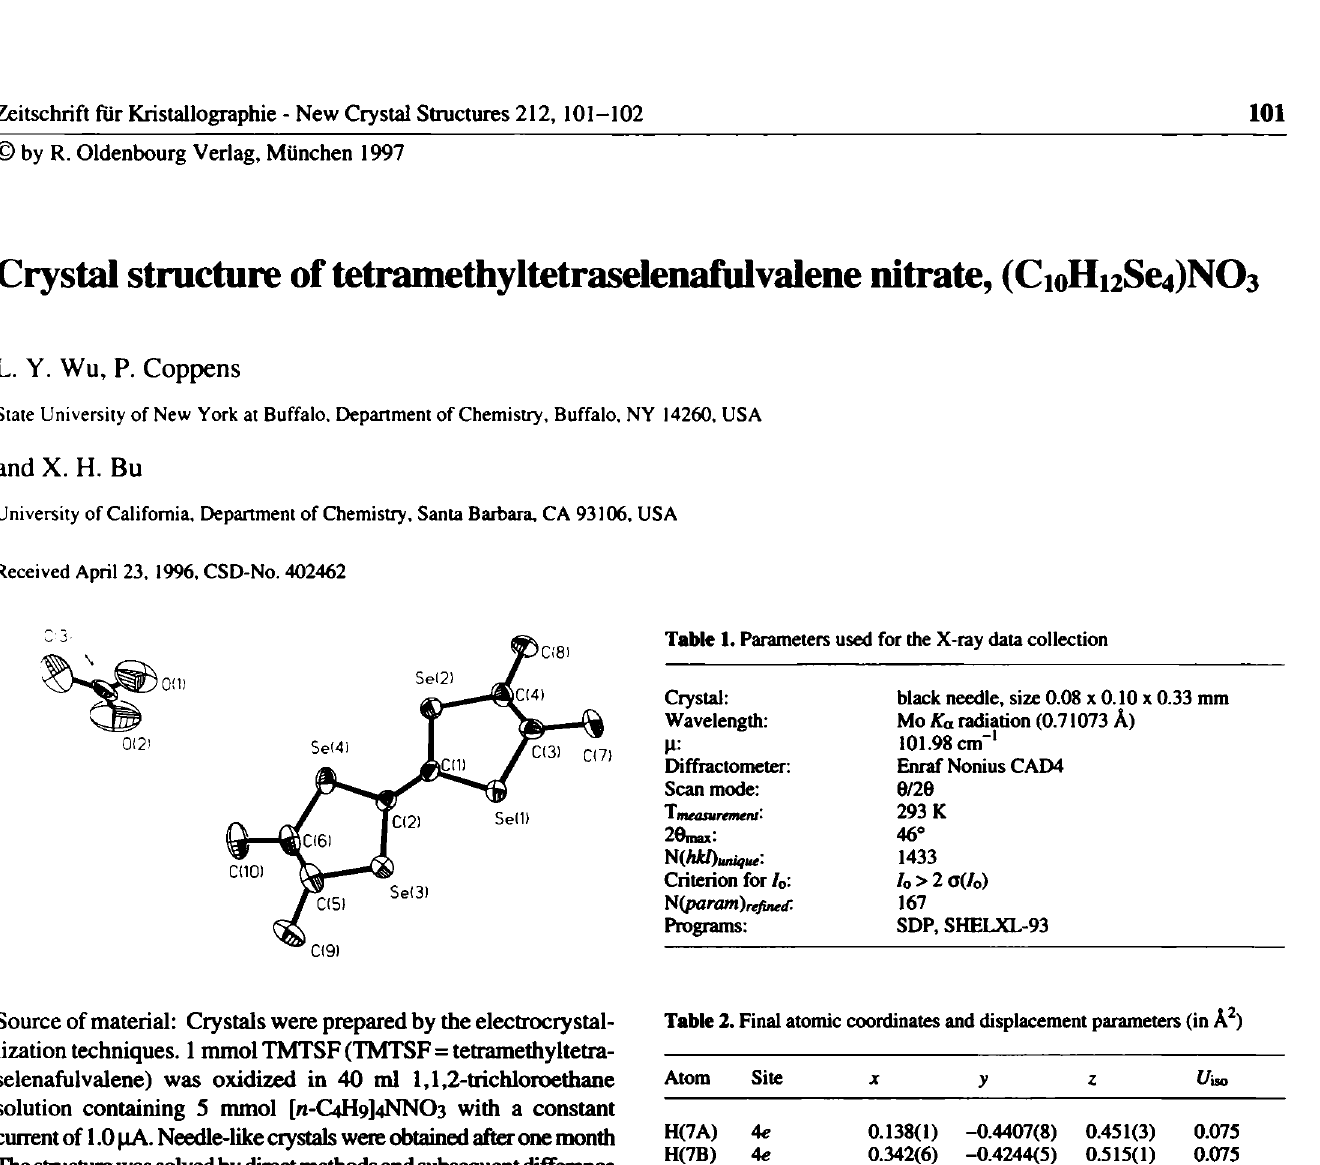
Table 3. Final atomic coordinates and displacement parameters (in Â 2 )